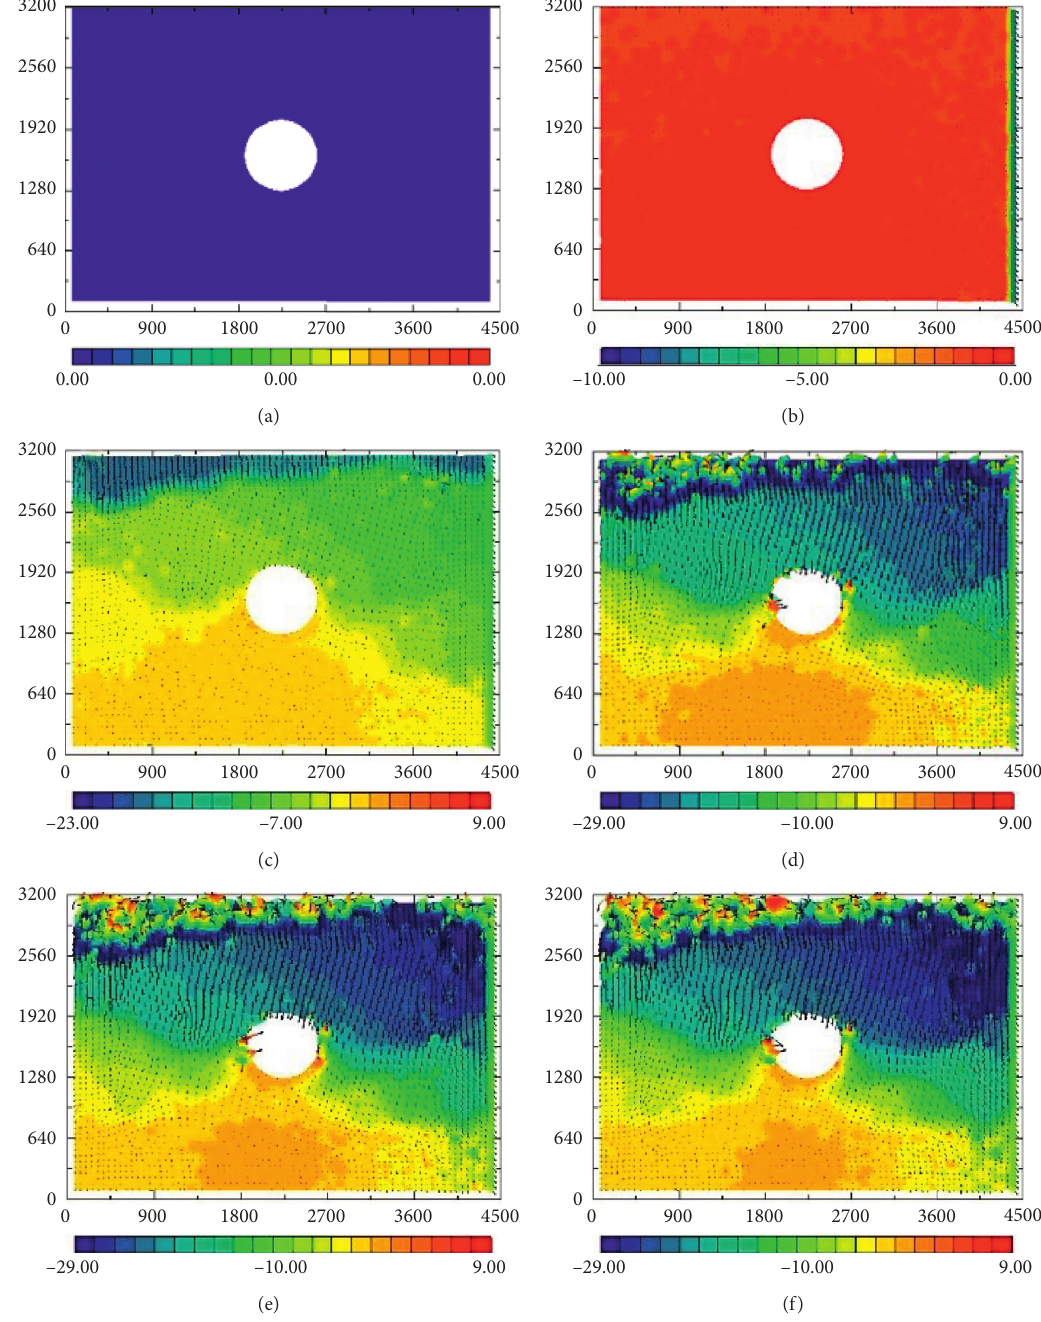
Figure 17: Vertical displacement cloud map with support mode. (a) 0.25MPa. (b) 0.32MPa. (c) 0.48MPa. (d) 0.58MPa. (e) 0.63MPa. (f)